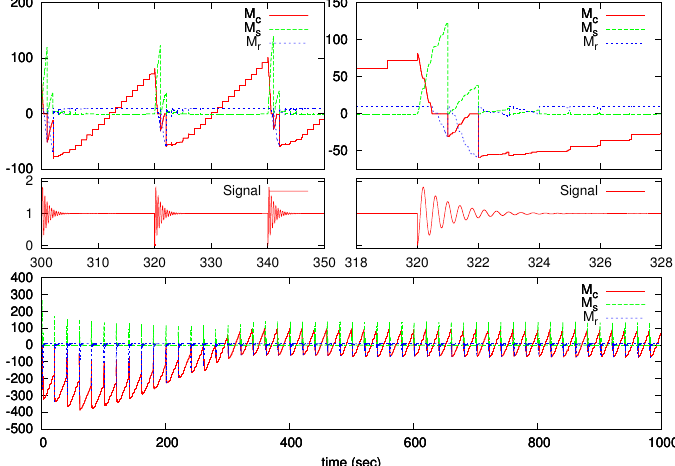
Figure 4. Algorithm behavior for the under-damped High-Oscillating signal. Details for the M s , M r and M c variables.